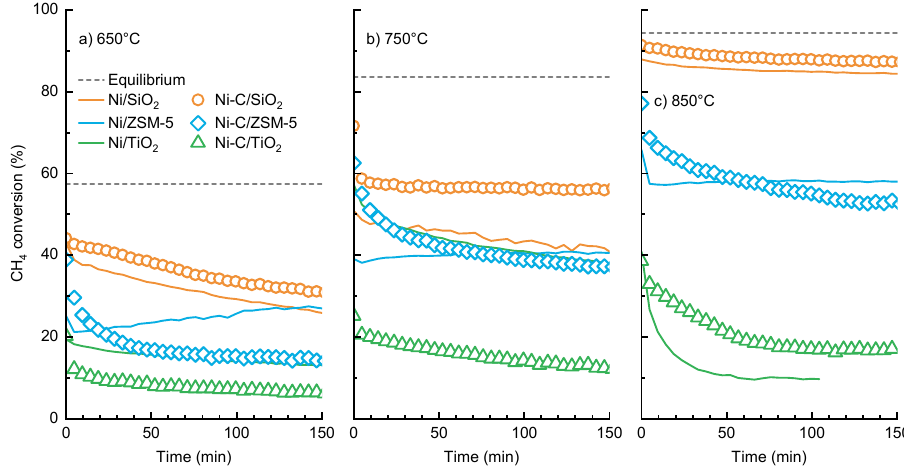
Figure 1. CH 4 conversion in DRM (dry reforming of methane) with prepared catalysts at different temperatures. ( a ) 650 ◦ C, ( b ) 750 ◦ C, ( c ) 850 ◦ C